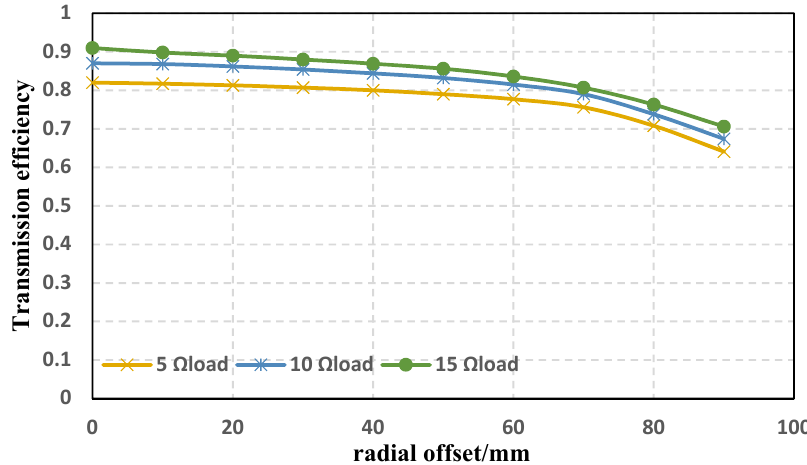
Figure 15. Transmission efficiency and anti-offset capability of the new coil under different loads.